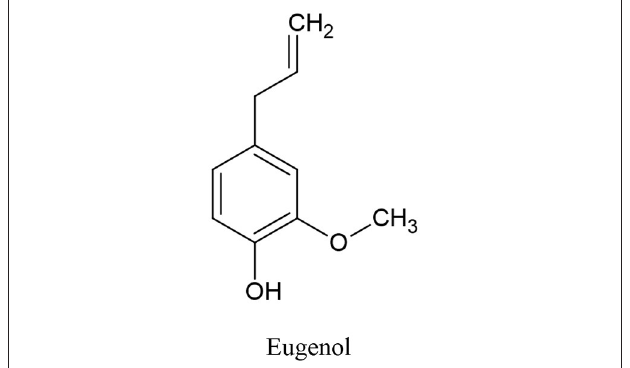
FIGURE 6 | Eugenol chemical